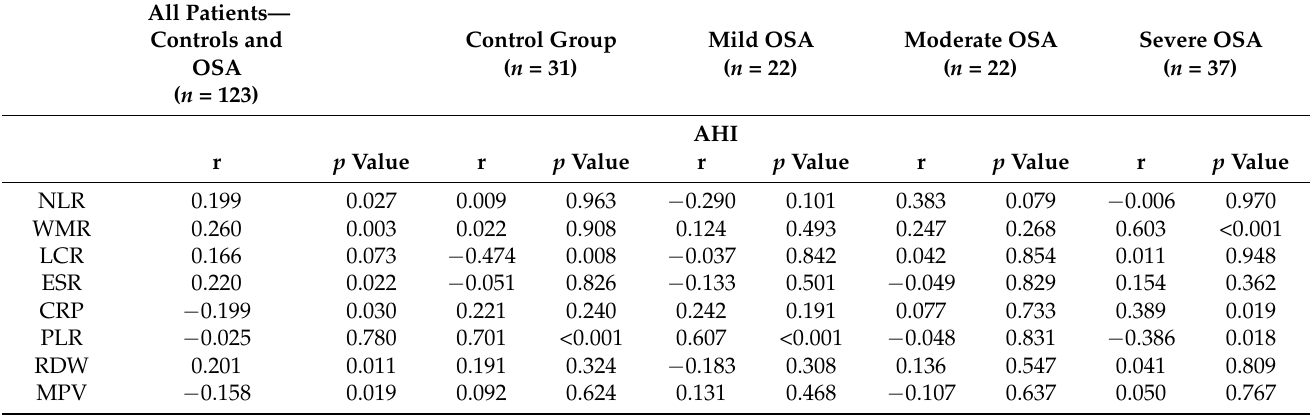
Table 2. Correlations between AHI and inflammatory parameters according to OSA severity.